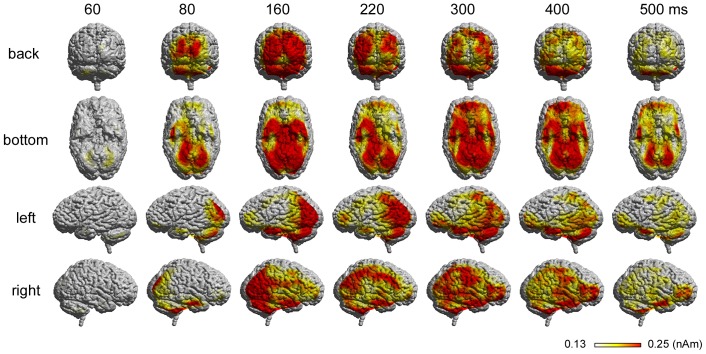
Spatially normalized CSD maps of the EmoFH condition averaged across 16 subjects.Each column shows the brain surface electric activity at a given time point. Each row shows the view from the back, bottom, left, and right.